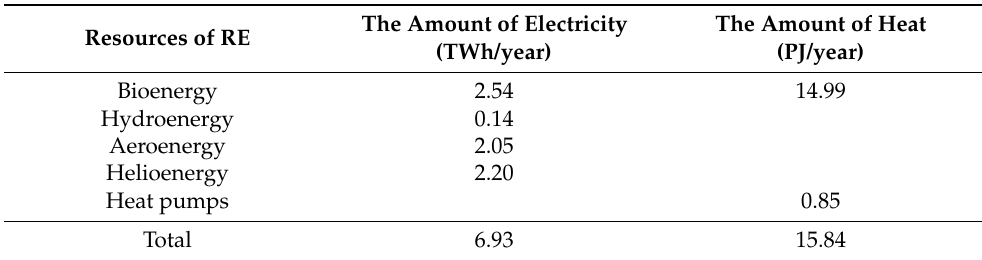
Table 6. The amounts of electricity and heat that can be obtained annually from RE in the Warmi´nsko- Mazurskie Voivodeship